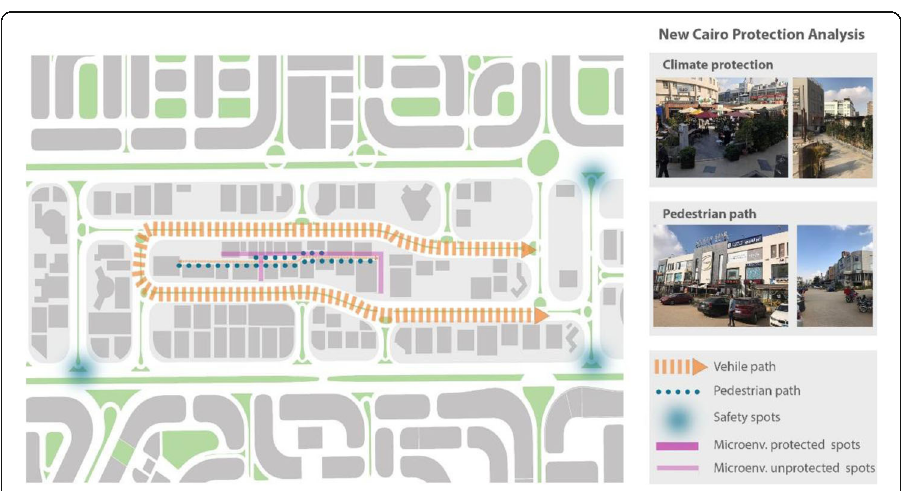
Fig. 11 New Cairo map, analysis of protection aspect in the Banks Street zone